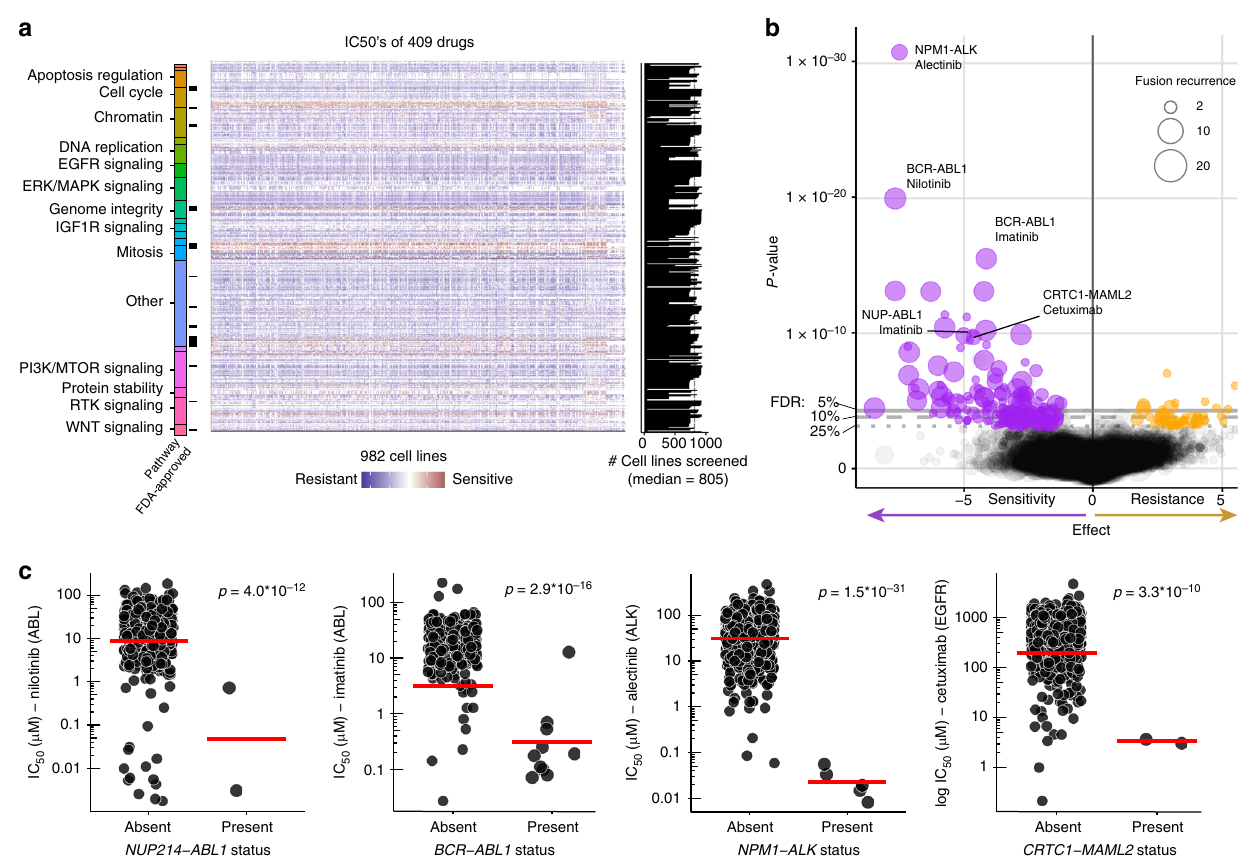
Fig. 3 Gene fusions as therapeutic biomarkers. a Genomics of Drug Sensitivity in Cancer (GDSC) drug sensitivity data utilized (reported as half-maximal inhibitory concentration (IC 50 ) values) with Food and Drug Administration (FDA)-approval status of compounds. Compounds are grouped by target or pathway. b Analysis of variance (ANOVA) results for fusion – drug associations. Each circle represents a tested association, with circle size indicating the number of cell lines harboring the associated fusion event (fusion recurrence), false discovery rate (FDR) thresholds are indicated. Negative effect sizes are associated with sensitivity and positive effect size resistance. Representative fusion – drug associations are labeled. c Examples of differential drug sensitivity in cell lines strati fi ed by fusion status. Nominal therapeutic drug targets are in brackets. Each circle is the IC 50 for an individual cell line and the red line is the geometric mean. Association signi fi cance values ( p values) are from the ANOVA